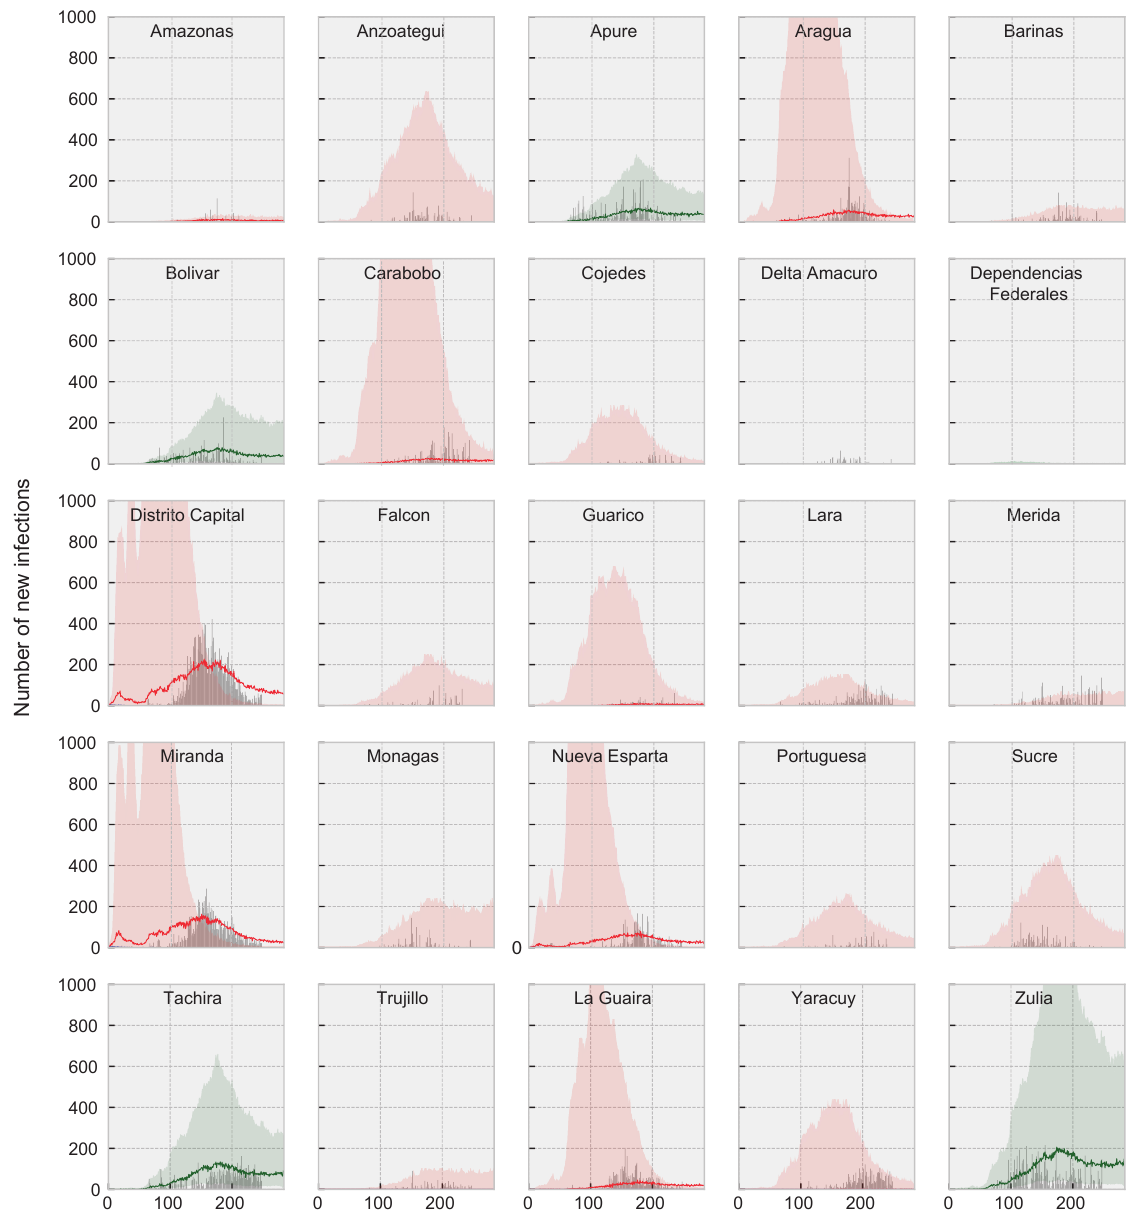
Figure A3. Daily infections with SARS-CoV-2 in Venezuela during the first 285 days. Gray bars are the number of cases confirmed with RT-PCR and reported by health authorities. The lines and shades are the mean and 50% confidence intervals of daily infections documented in non-border (red) and border (green) states predicted by the SEI metapopulation model, assuming that only 25% of all cases are